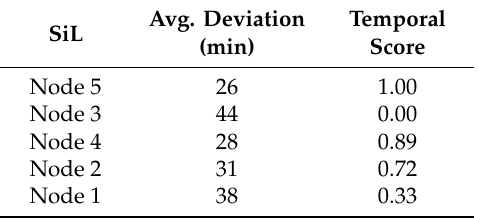
Table 5. Temporal score calculation of the sample